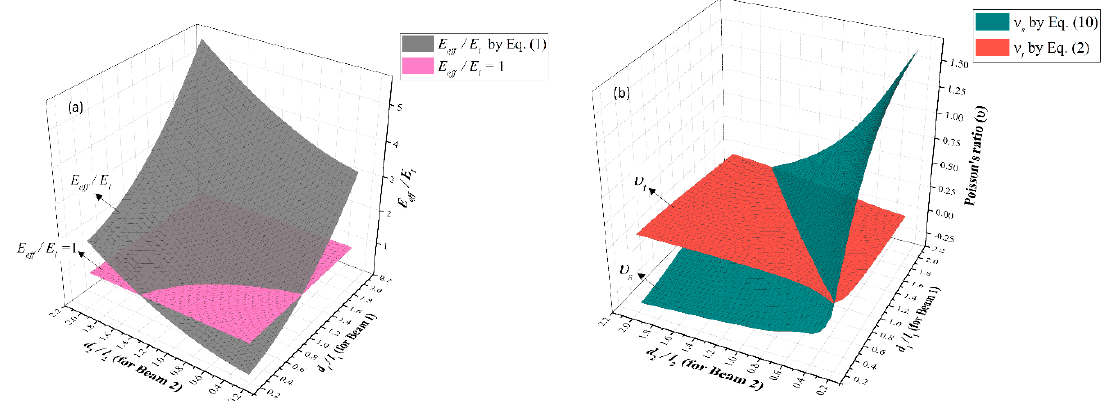
Figure 9. Homogeneous and isotopic lattice model for a 20 × 20 × 20 μ m 3 REV for variations of d 1 / l and